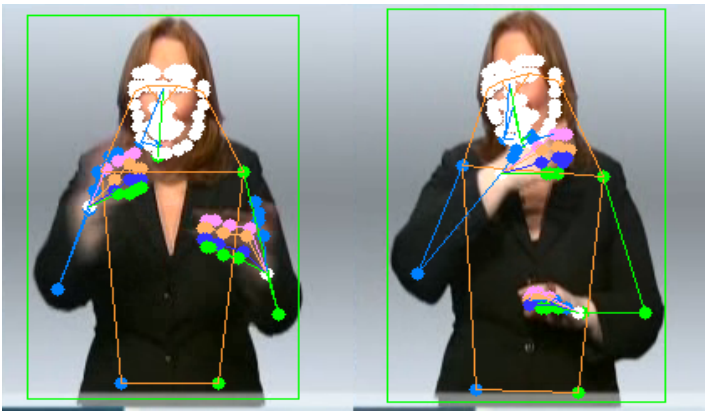
Figure 6. Illustration of defect frames on RWTH-PHOENIX dataset [33,39]. Some of the keypoints in the hand area are in the wrong position due to blurry images.